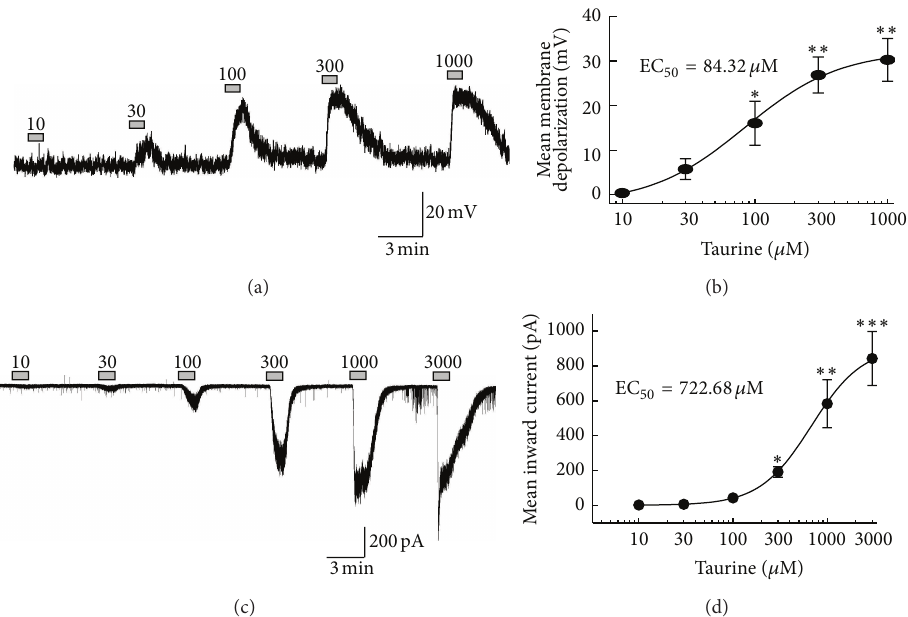
Figure 3: Concentration-response relationship. (a), (c) Representative traces of SG neurons showing the changes of membrane depolarizations and inward currents to different doses of taurine (10, 30, 100, 300, 1,000, 3,000 𝜇 M). (b), (d) Curve figures showing the mean membrane potentials and the mean inward currents change which correspond with the concentration changes ( ∗ 𝑃 < 0.05 , ∗∗ 𝑃 < 0.01 , ∗∗∗ 𝑃 < 0.001 , one-way ANOVA, Scheffe’s post hoc test).